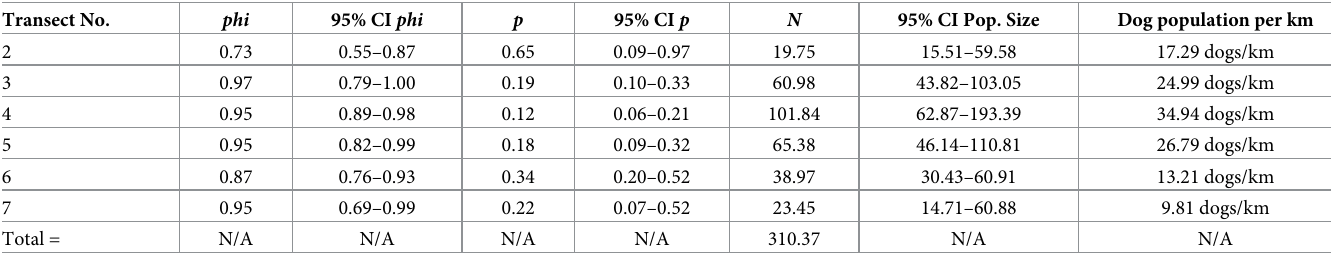
Estimated values and 95% confidence intervals for phi (survival probability), p (capture probability), and N (population size) for transects 2–7. Weighted averages for each value were calculated for Transect 7. The last column shows the estimated dog population size for each transect divided by the transect length in kilometers. These values serve to control for variation in transect length when comparing the dog population size between